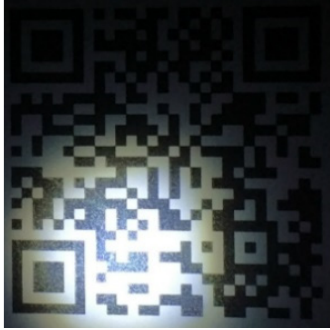
Figure 4. Image P1. Figure 4. Image P1.